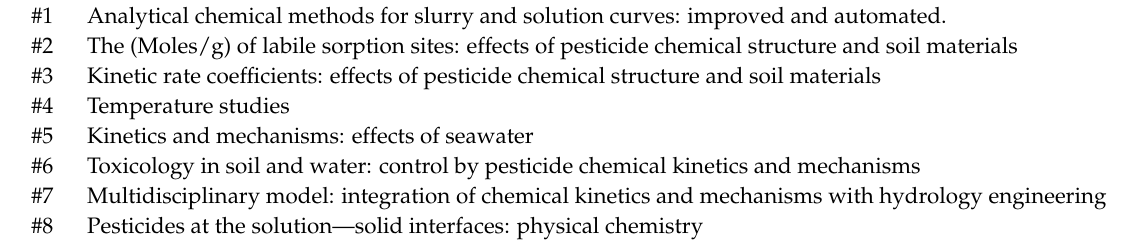
Table 1. New Research Projects Required for Pesticides in Soil and Water Analytical chemical methods for slurry and solution curves: improved and